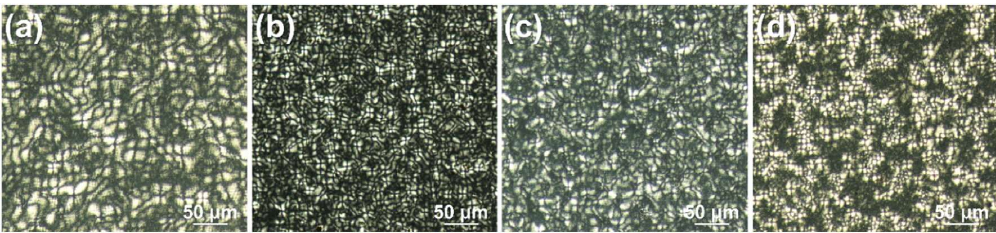
Figure 3. Liquid-crystalline polyesters reprocessed with various carbon nanomaterials. Polarized